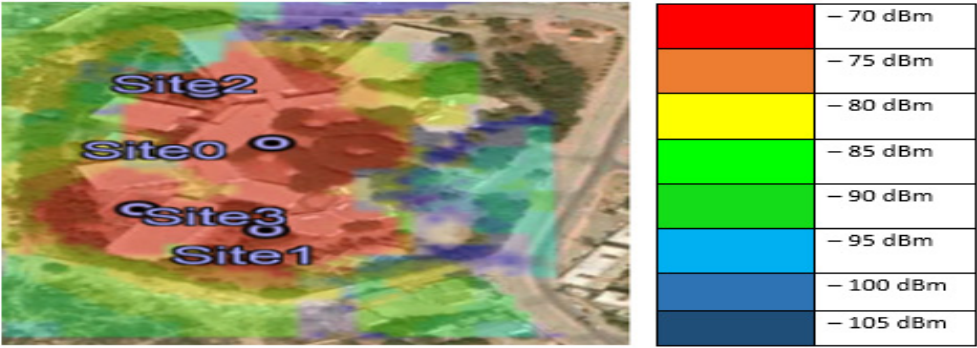
Figure A3. Prediction of power level coverage in ENST campus with three base stations.